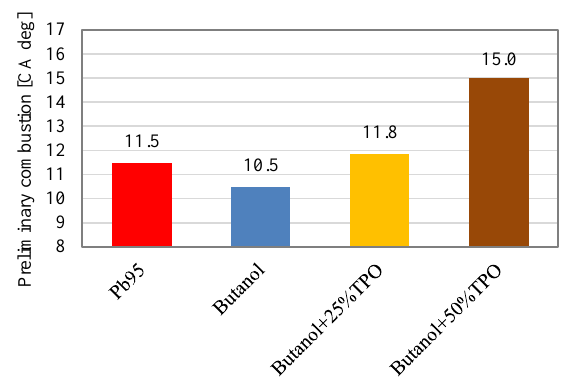
Fig. 8. Preliminary combustion for various fuel in [CA deg]